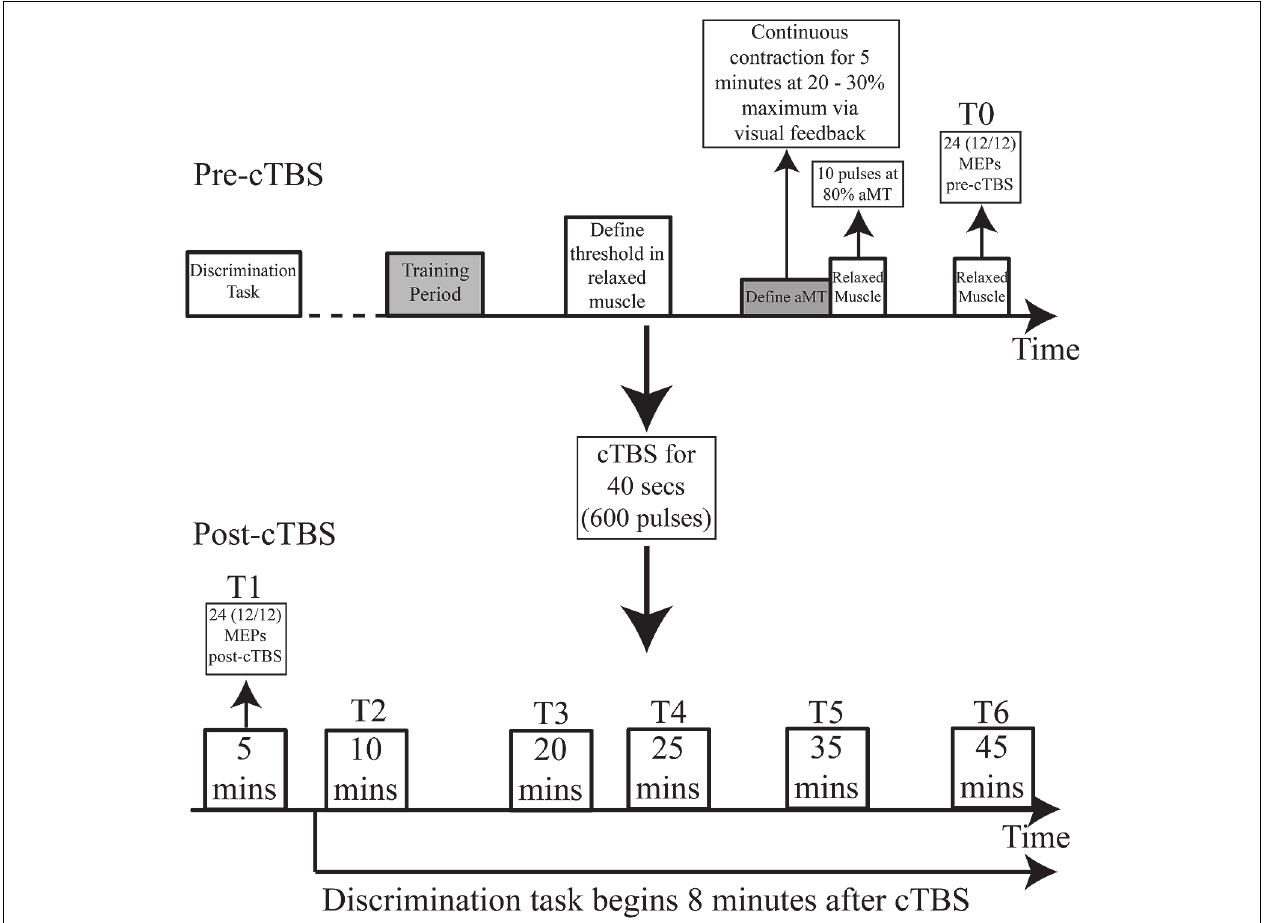
FIGURE 1 | Experimental procedure: cTBS applied for 40 s. 12 MEPs recorded from the target (lip or hand) and non-target (lip or hand) muscle (24 in total) before cTBS (T0) and 5 (T1), 10 (T2), 20 (T3), 25 (T4), 35 (T5), and 45